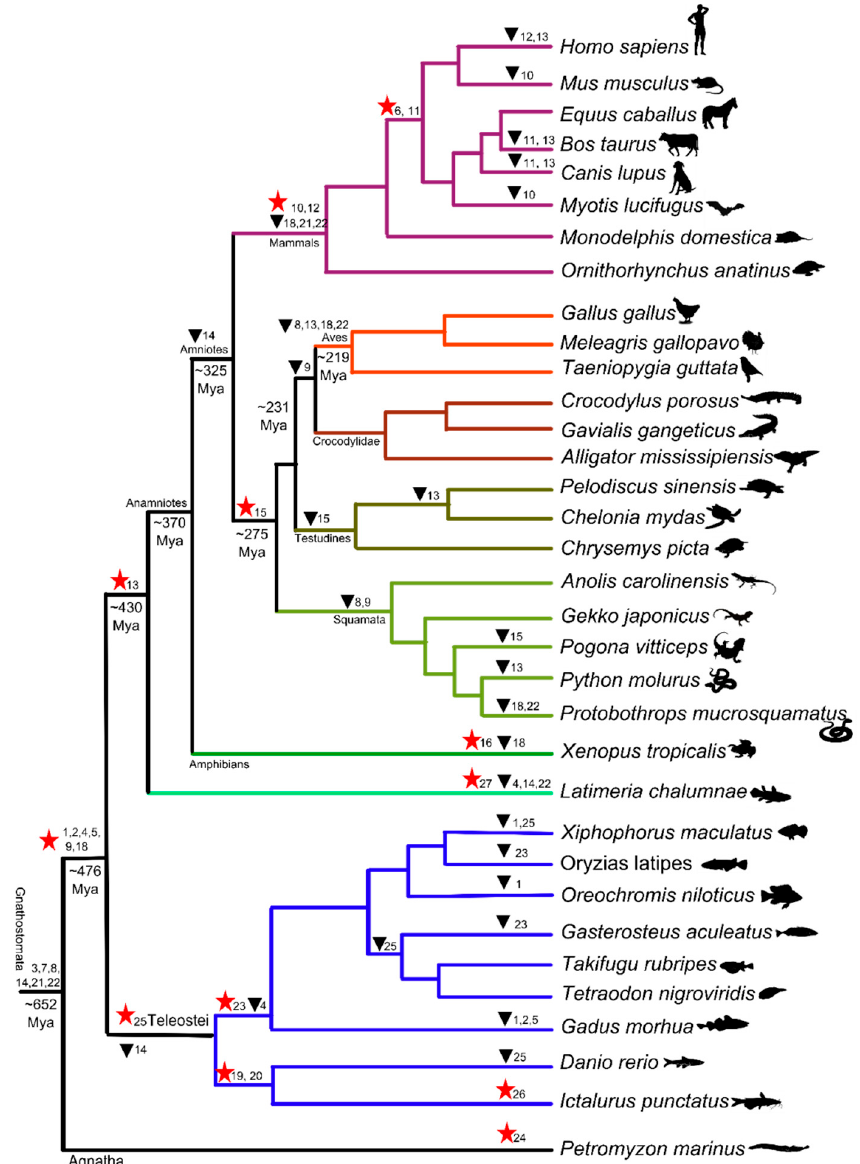
Figure 2. Molecular evolution of vertebrate TLR gene family with events of TLR subfamily gains and losses shown on the consensus phylogeny made based on published literature. The dates were inferred using http://www.timetree.org/. The gains are represented by a star and the triangle shows loss of TLR subfamily.